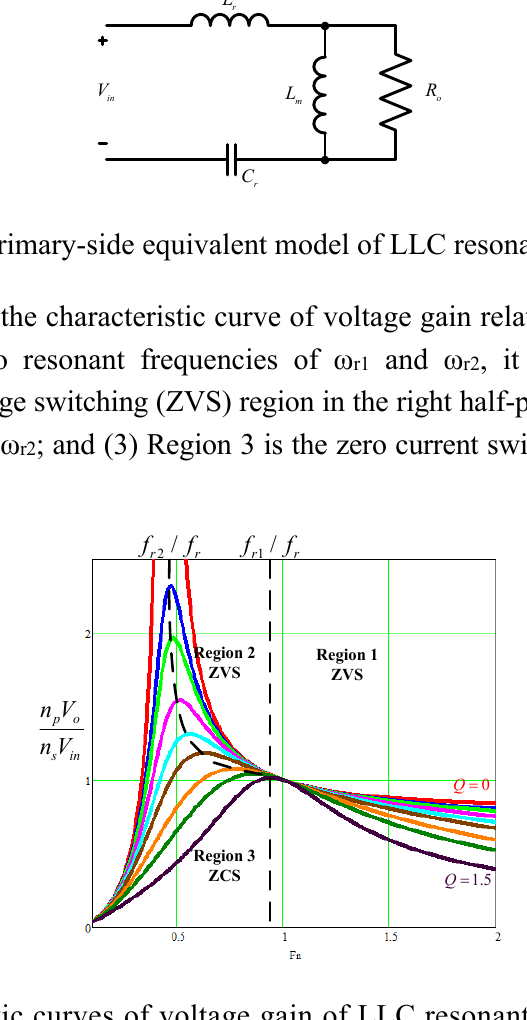
Figure 5. Characteristic curves of voltage gain of LLC resonant converter with respect to